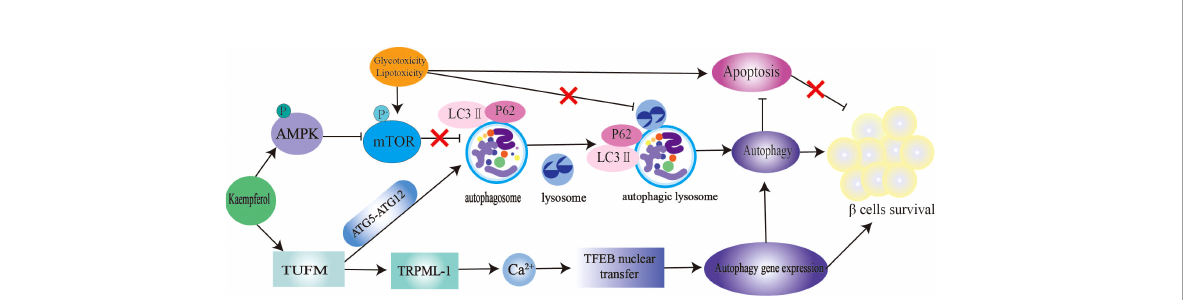
FIGURE 4 Kaempferol stimulates autophagy to protect pancretic b Cells. Kaempferol up regulates intracellular lipid autophag of b cells by activating AMPK/ mTOR signal pathway and TUFMTFEB signal pathway. Thus inhibiting b Apoptosis, restore autophagy-apoptosis balance, and protect pancreas b Cells. AMPK, AMP-activated protein kinase; mTOR, rapamycin; LC3, microtubule-associated protein light chain 3; ATG5, autophagy-related geneS; ATG12, autophagy-related gene 12; TUFM, Tu translation elongating factor, mitochondrial; TRPML-1, transient receptor potential mucolipin 1; TFEB, nuclear translocation of transcription